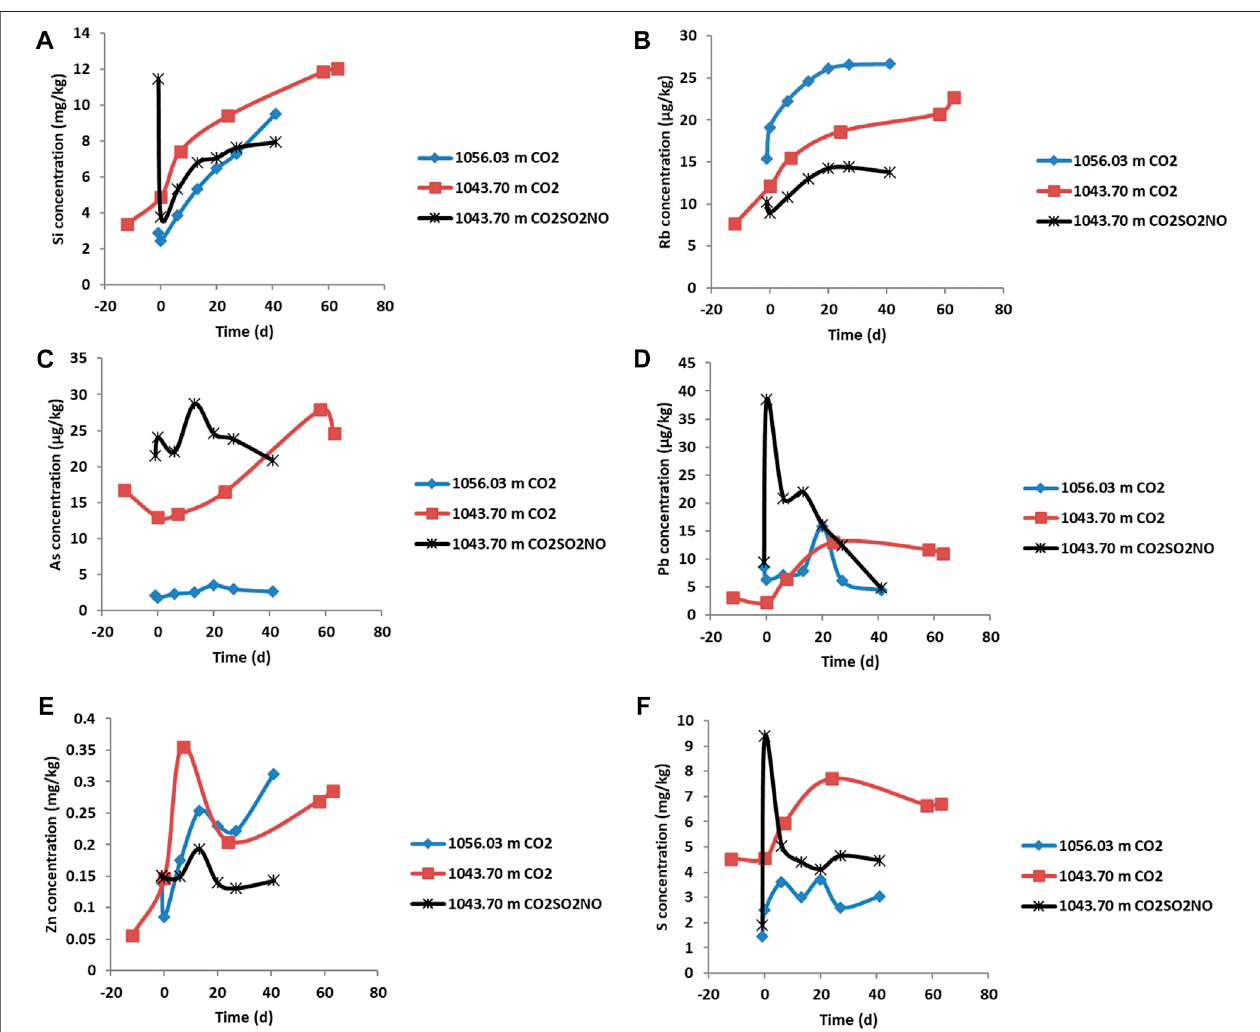
FIGURE 8 | Dissolved element concentrations during the reactions of Evergreen Formation core with CO 2 or CO 2 SO 2 NO. The negative time points represent the water composition and water rock interaction, and the CO 2 gas was introduced at time zero. (A) Concentration of Si (mg/kg), (B) Rb (µg/kg), (C) As (µg/kg), (D) Pb (µg/kg), (E) Zn (mg/kg), and (F) S (mg/kg).